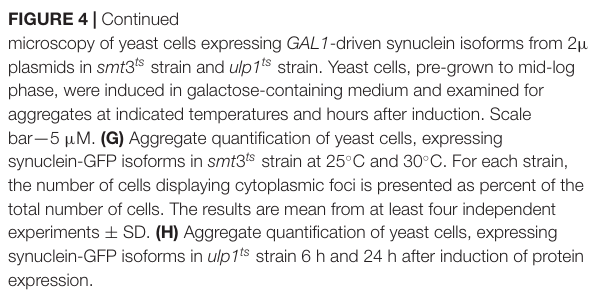
FIGURE 4 | Continued microscopy of yeast cells expressing GAL1 -driven synuclein isoforms from 2 µ plasmids in smt 3 ts strain and ulp1 ts strain. Yeast cells, pre-grown to mid-log phase, were induced in galactose-containing medium and examined for aggregates at indicated temperatures and hours after induction. Scale bar—5 µ M. (G) Aggregate quantification of yeast cells, expressing synuclein-GFP isoforms in smt 3 ts strain at 25 ◦ C and 30 ◦ C. For each strain, the number of cells displaying cytoplasmic foci is presented as percent of the total number of cells. The results are mean from at least four independent experiments ± SD. (H) Aggregate quantification of yeast cells, expressing